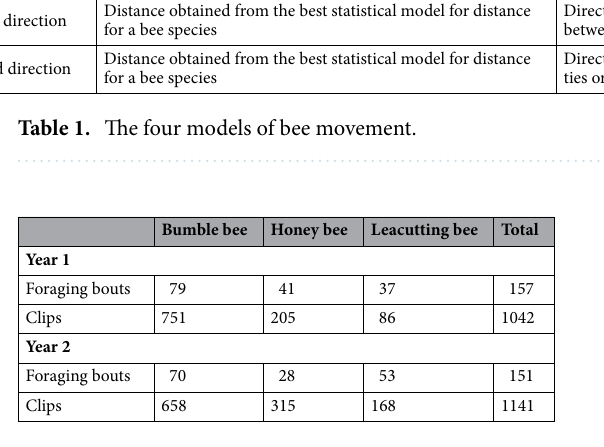
Table 2. Sample sizes per bee species per year for foraging bouts and clips. A foraging bout includes all the racemes visited in one visit to the patch by a bee. A clip represents two successively visited